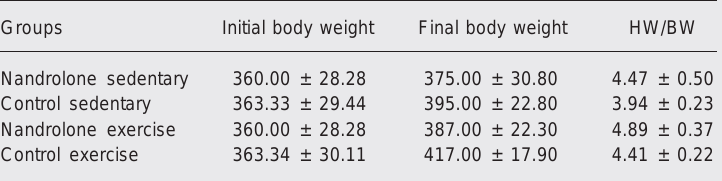
Table 1. Effect of nandrolone and exercise on body weight and heart weight to body weight ratio (HW/BW).